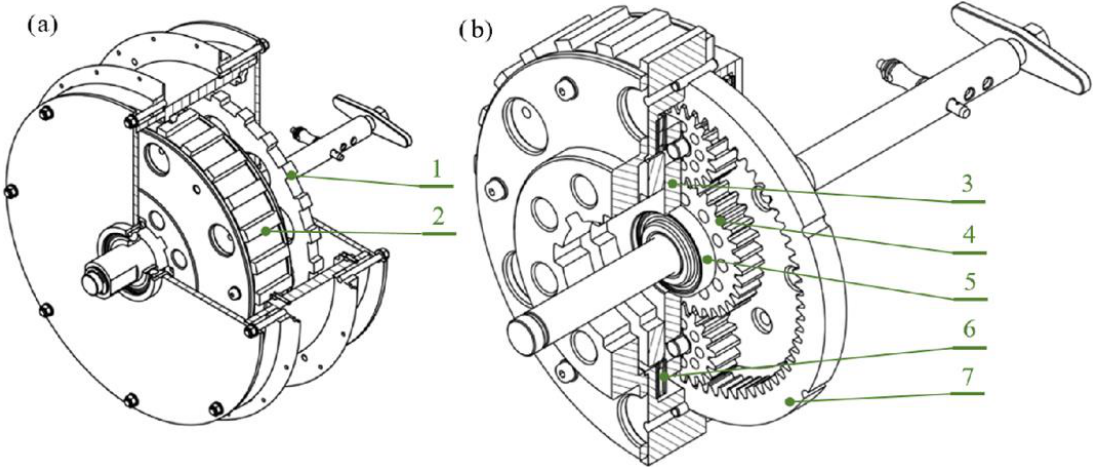
Figure 2. View of the diagram of the constructed planetary gear: ( a ) view of the internal gear hub and methods of coupling the planetary gear; 1 — splined disc, 2 — splined ring, ( b ) view of the bearing system of the carrier inside the planetary gear; 3 — carrier, 4 — sun gear, 5 — radial bearing, 6 — axial bearing and 7 — ring gear (internal teeth).